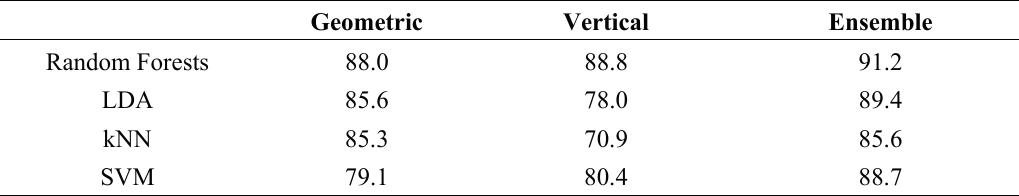
Table 3. Classification accuracies (%) with using different base